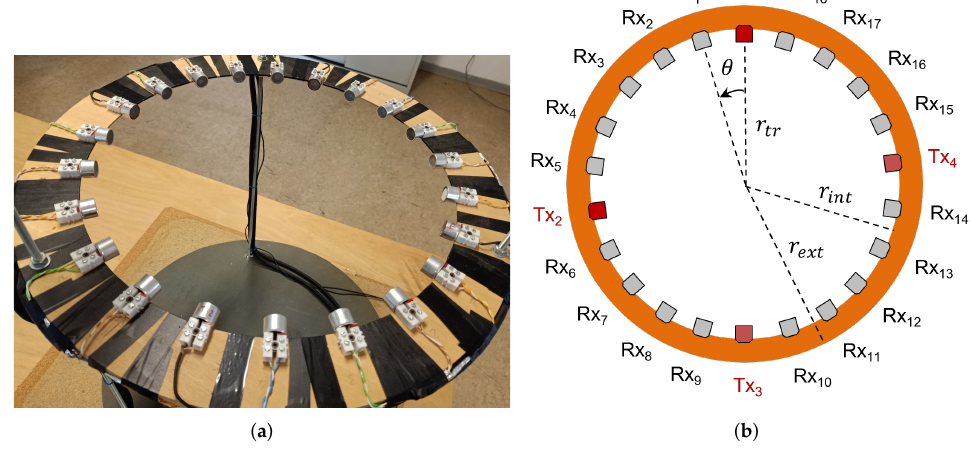
Figure 2. ( a ) Picture of the US transducers circular array and ( b ) sketch of its arrangement with details about transmitters (in red) and receivers (in grey). The dimensions are: r int = 17.5 cm, r ext = 22.5 cm, ◦ r tr = 16.5 cm and θ = 16.36